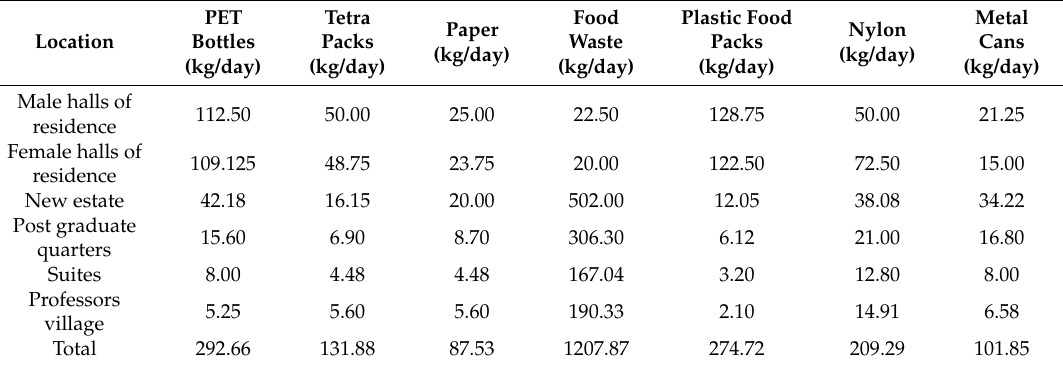
Table 5. Material comparison of waste from residential areas for staff.